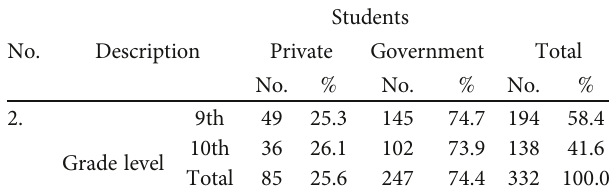
T ABLE 2: Students grade level versus school-type